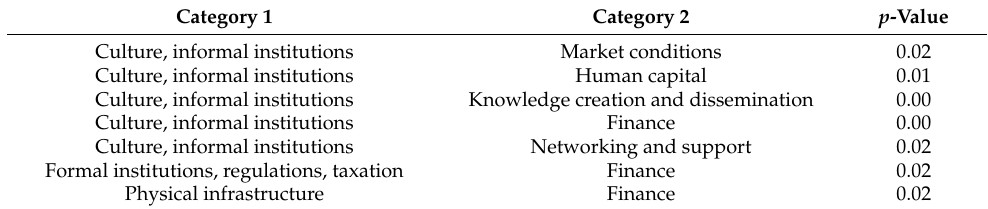
Table 1. Results of post hoc